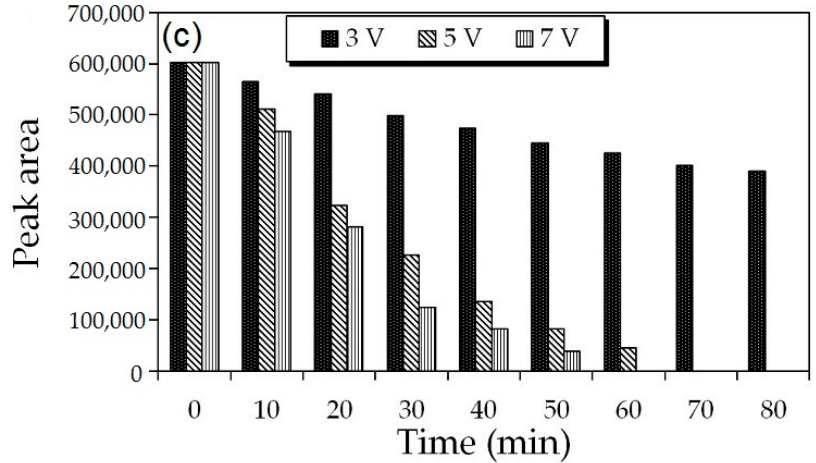
Figure 1. Effect of changing ( a ) initial concentration of hydrochlorothiazide on the removal% (0.5 g NaCl and 5 V); ( b ) amount of sodium chloride on the removal% (2 mg/L of HDZ and 5 V); ( c ) applied voltage on the removal% (2 mg/L of hydrochlorothiazide (HDZ) and 0.5 g NaCl) throughout electrochemical oxidation process of 100 mL solution.